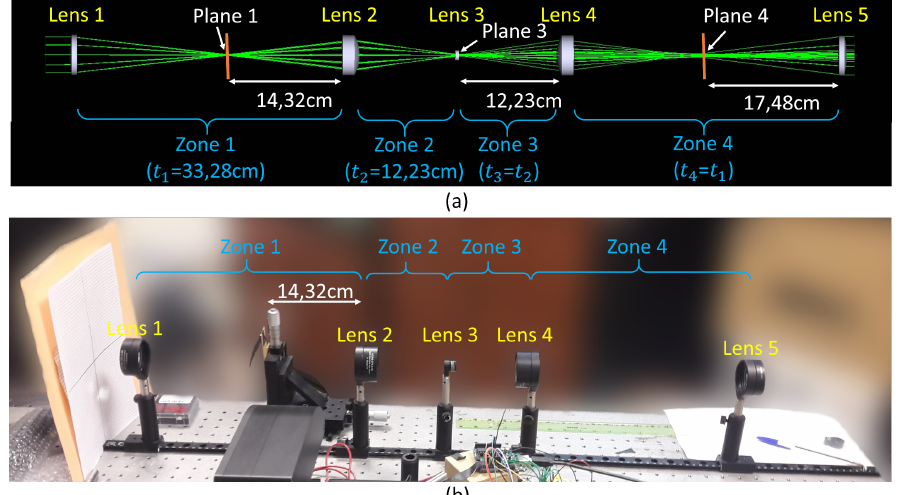
Figure 6. Case with f 3 = − 25 mm, simulated and experimental system. ( a ) Simulation of the ray tracing and zones for the case f 3 = − 25 mm. ( b ) Experimental system for the case f 3 = − 25